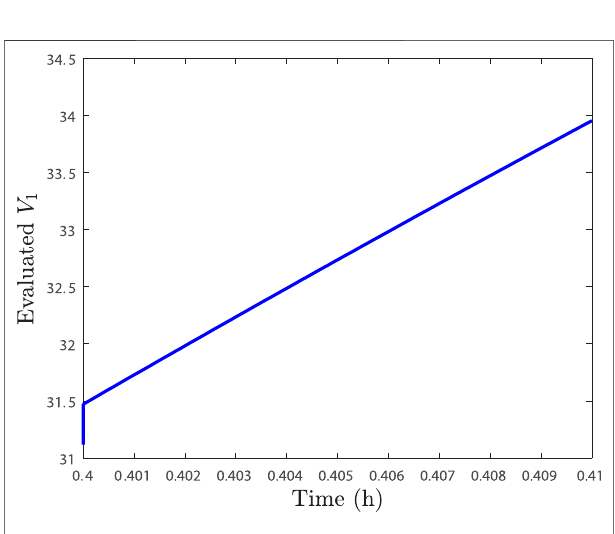
FIGURE 4 | V 1 pro fi le along the measurement trajectory over one sampling period after 0.4 h of operation for the process example in the presence of multiple cyberattack policies (baseline case).